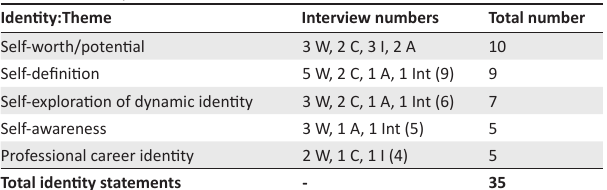
TABLE 4: Identity of women